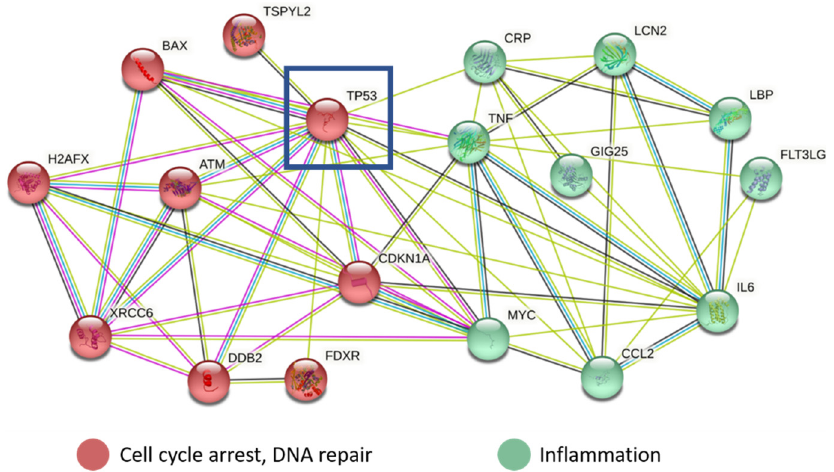
Figure 2. STRING db analysis of the top candidate proteins for biological dosimetry. The network represents the connection between the single proteins. The two clusters presented allocate the proteins to specific molecular functions such as cell cycle arrest and DNA repair in red and inflammation in green.